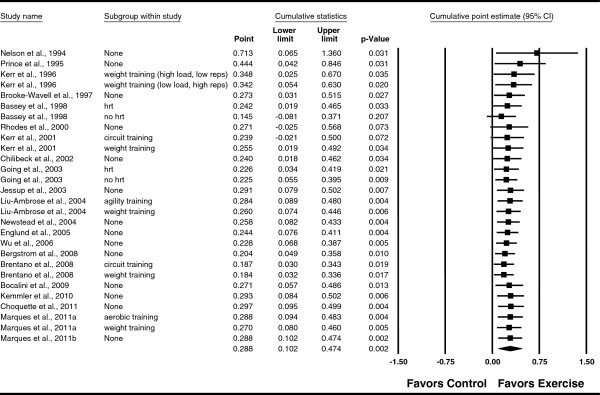
Cumulative meta-analysis for changes in FN BMD. Cumulative meta-analysis, ordered by year, for point estimate standardized effect size changes (g) in FN BMD. The black squares represent the standardized mean difference (g) while the left and right extremes of the squares represent the corresponding 95% confidence intervals. The results of each corresponding study are pooled with all studies preceding it. The middle of the black diamond represents the overall standardized mean difference (g) while the left and right extremes of the diamond represent the corresponding 95% confidence intervals. For subgroup, HRT means hormone replacement therapy.